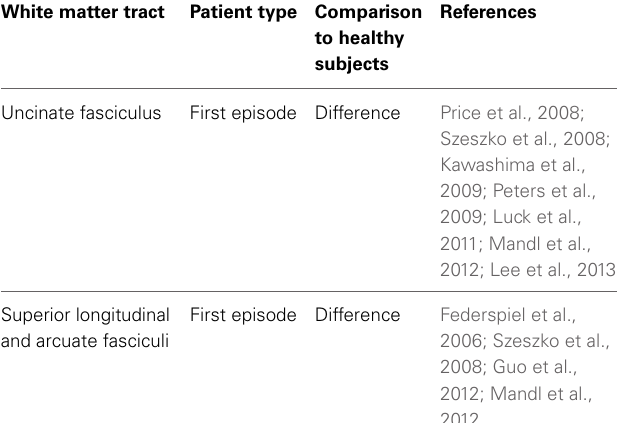
Table 2 | White matter tract alterations in first episode and medication naïve patients with